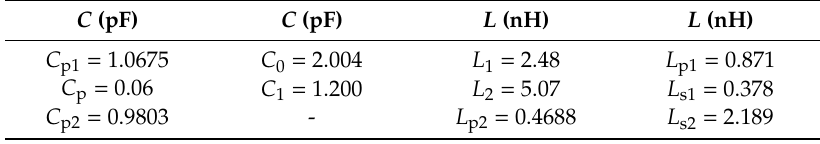
Table 2. The extracted parameters in Figure 10c by using ADS.